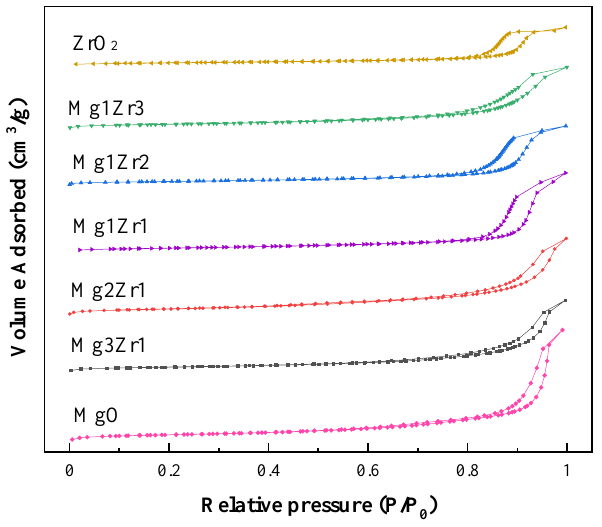
Figure 4. N 2 adsorption-desorption isotherms of Mg-Zr oxides with different Mg/Zr ratios. The specific surface area, pore diameter, and pore volume of the catalysts are listed in Table 3. It can be seen that the specific surface area of Mg1Zr2 is 68.8 m 2 /g, and then the specific surface area increases with the addition of Mg, which is consistent with the experimental results of Guan [36]. As the Mg content increased, the specific surface area of Mg-Zr oxide catalysts has an upward trend, which may be due to the multi-layer dispersion of MgO attached to the surface of magnesium-zirconium solid solution, resulting in the increase of specific surface area. MgO has the largest specific surface area, but the catalytic performance is not the best, indicating that although the structure of the catalyst has a certain impact on the catalytic performance, it is not a completely decisive factor.